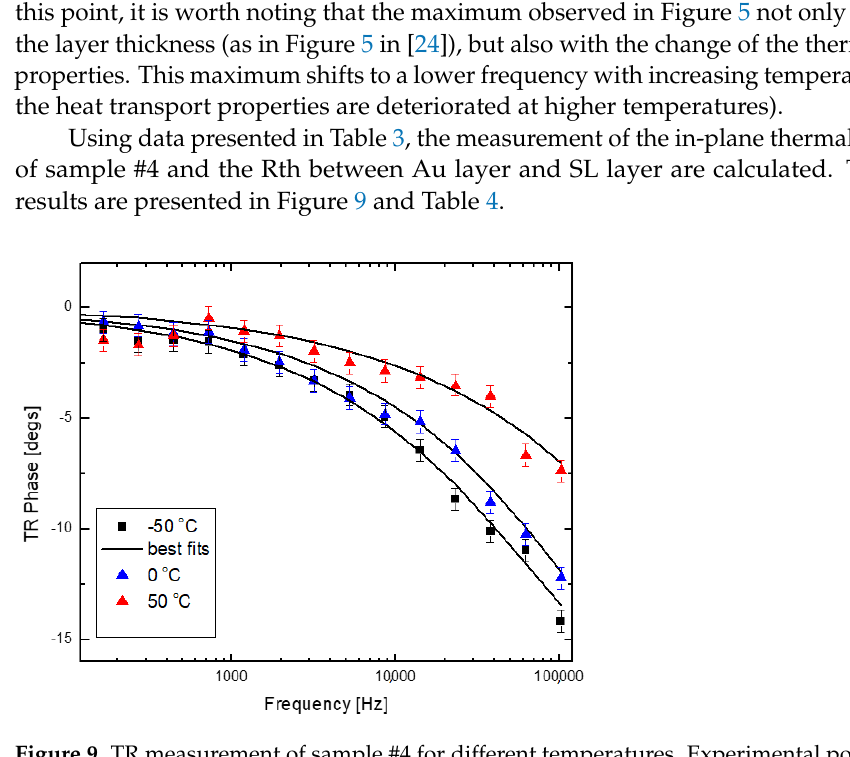
Figure 9. TR measurement of sample #4 for different temperatures. Experimental points are circles, while fits are lines. The red (50 ◦ C), black ( − 50 ◦ C) and blue (0 ◦ C). The best fits are obtained using Equation (1). Table 4. In-plane thermal transport parameters of AlAs/GaAs superlattice obtained from fits to the PTR data in Figure 5 for different